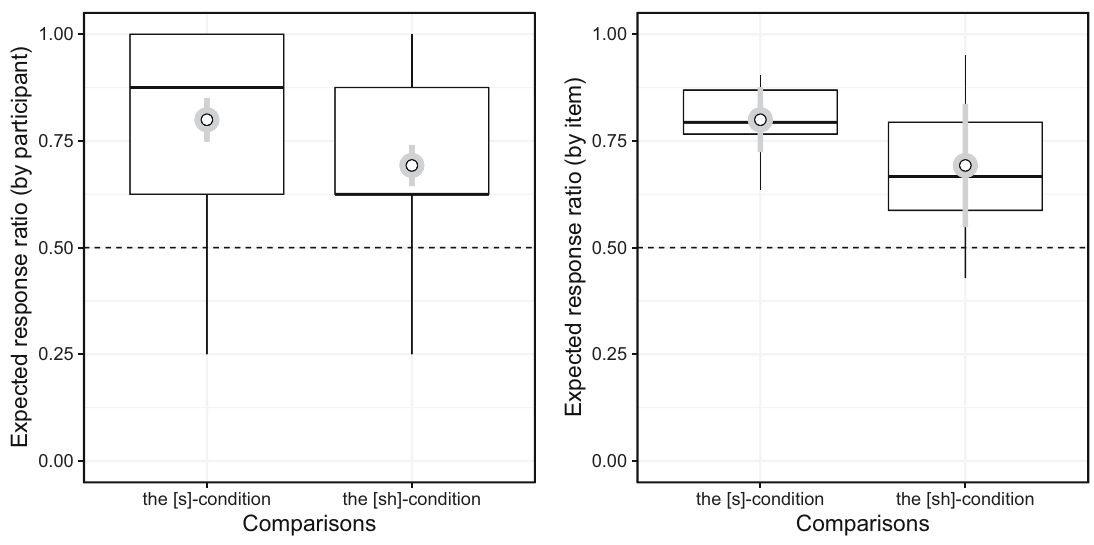
Figure 2: Box plots illustrating the distributions of expected response ratios ( the small data set ) , by participant ( left ) and by item ( right ) . The white circles represent the grand averages. The gray bars around the white circles represent the 95% con fi dence intervals around these